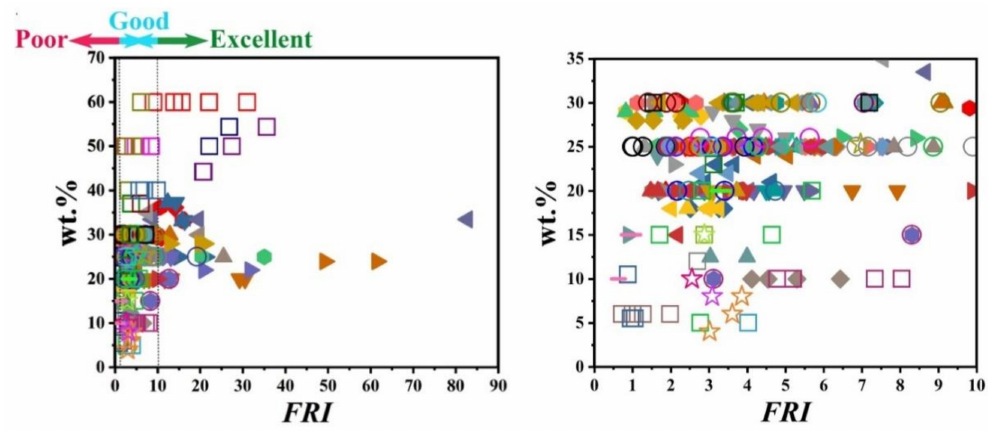
Figure 15. FRI values as a function of combinatorial FR additives and their content in PP in long‐shot (left‐hand figure) and close‐up (right‐hand figure) views. Symbols are indicative of different types of combinatorial flame retardant used. Here: (cid:78) APP-13.2 / PER-6.8 [68], (cid:72) APP-16.7 / PER-8.3 [143], APP-18.7 / PER-6.3 [67], APP-22.5 / PER-7.5, mc-(APP-22.5&PER-7.5) [144],